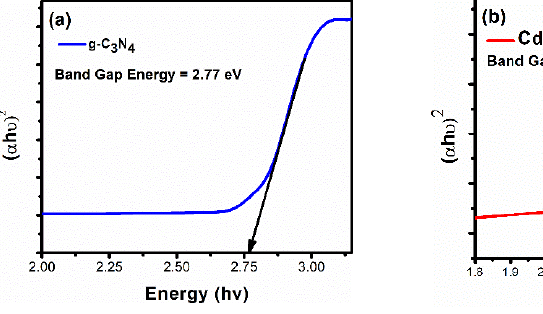
Figure 4. Tauc Plots of all the prepared materials, ( a ) pure g-C 3 N 4 , ( b ) CdO nanorods, and ( c ) CdO- -g-C 3 N 4 photocatalysts showing band gap energies (Eg). The band gap of the composite lies in be- tween both of pure g-C 3 N 4 , CdO